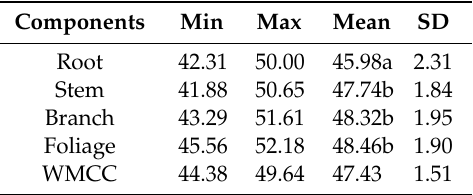
Table 6. Carbon concentration (%) by components along with the weighted mean carbon concentration (WMCC) statistics for Populus × xiaohei